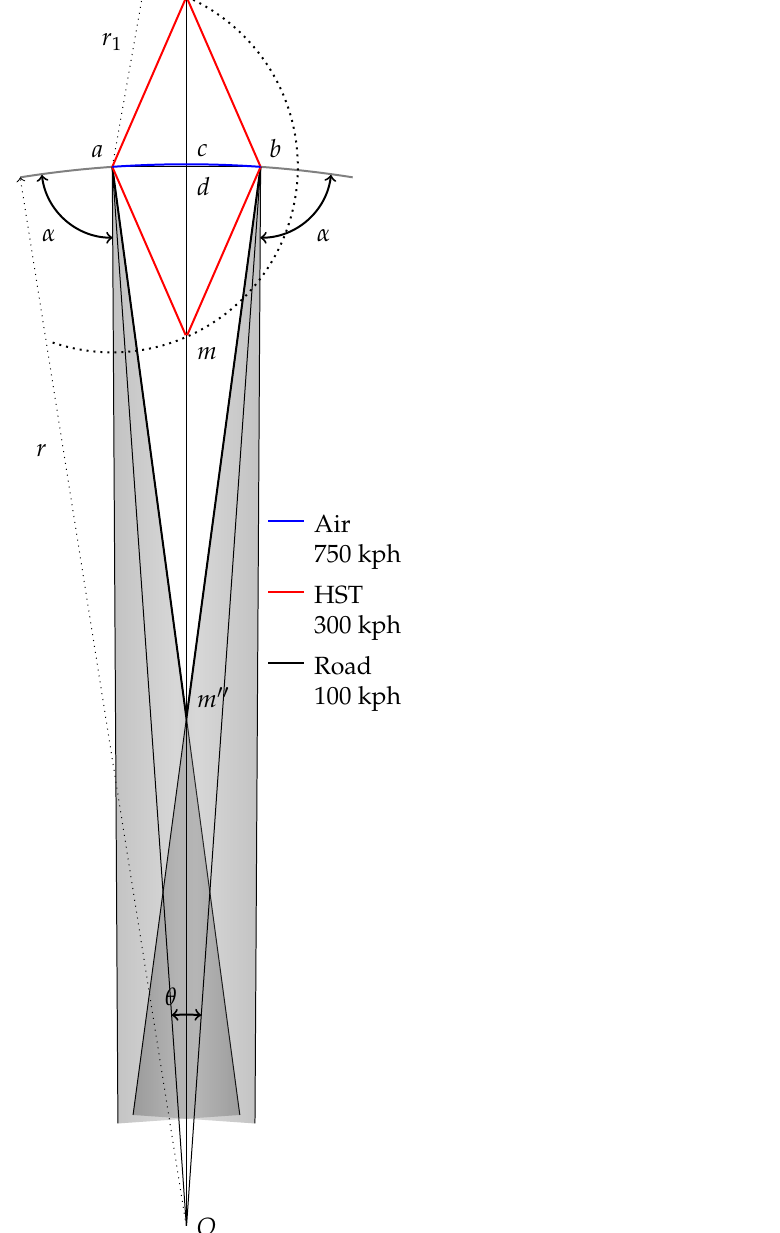
Figure A2. Drawing edges and cones with different speed in the spherical